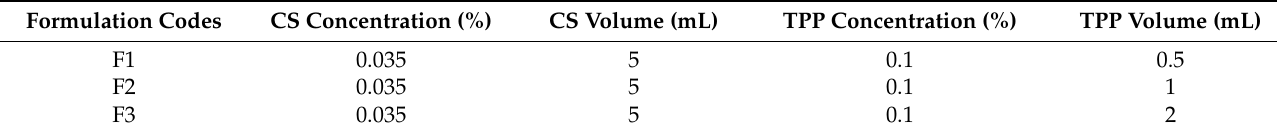
Table 1. Formulations of CS-TPP NPs by changing the added TPP volume.